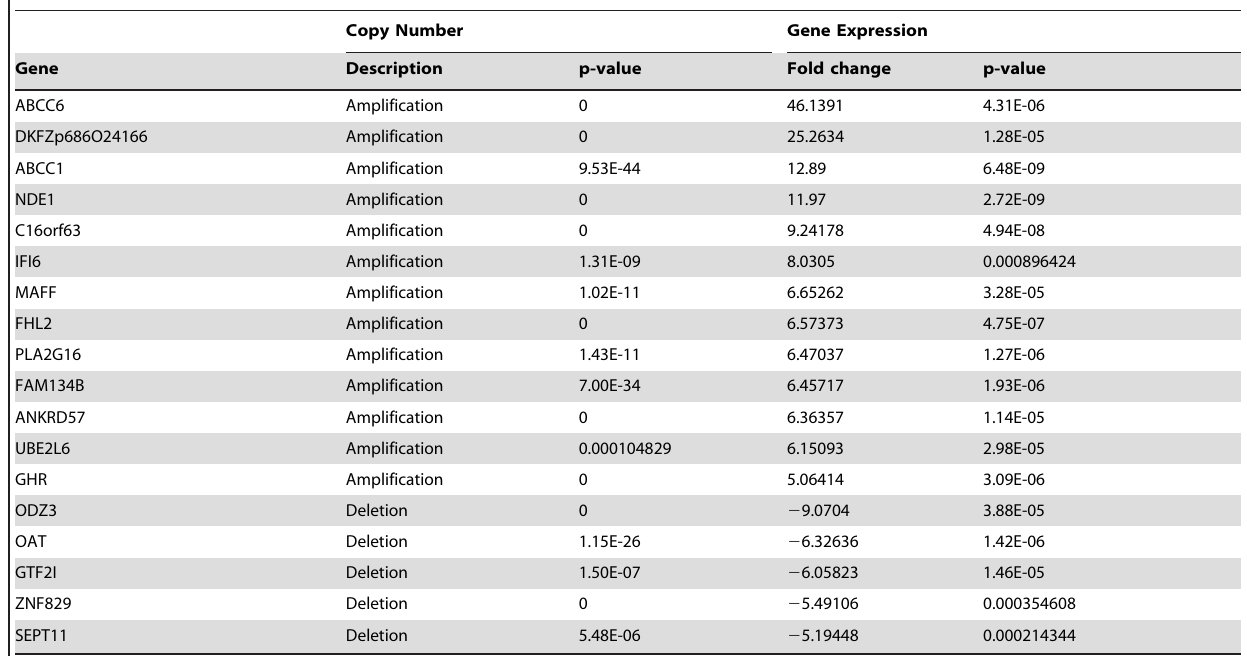
Table 2. Correlated copy number and gene expression data.